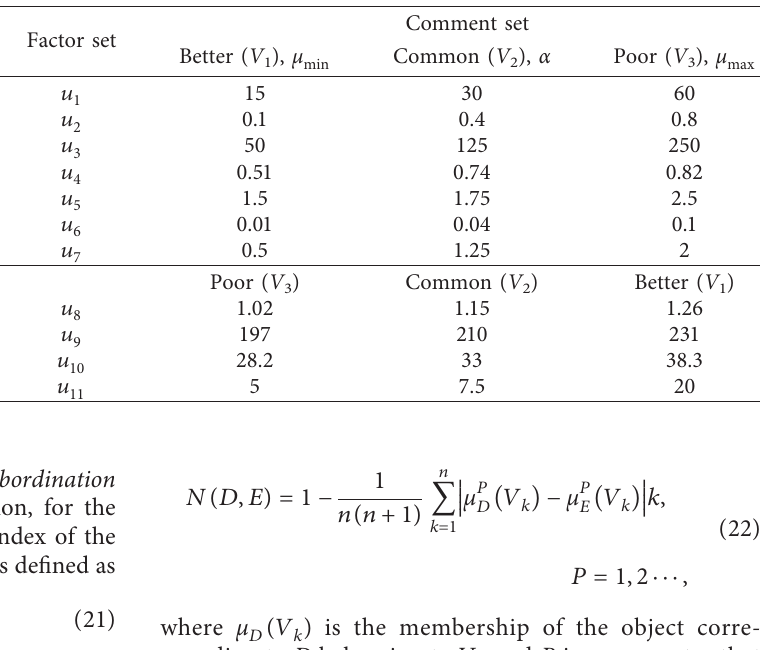
Table 1: Expected value of the state